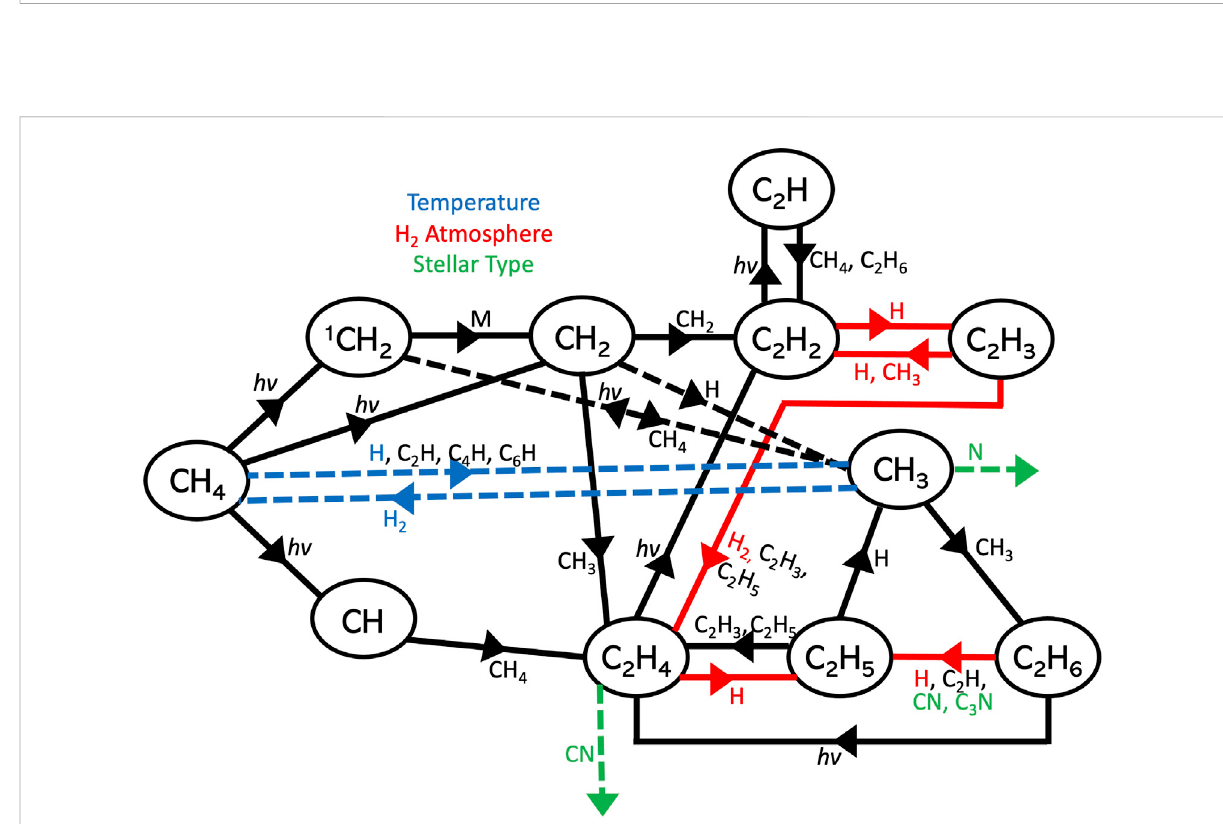
Diagram of important reactions relevant to hydrocarbon chemistry at Exo-Titans, based off the Titan chemistry presented in Yung et al. (1984). Reactions highlighted in blue show those with a large temperature dependence, thus dominating the chemistry in warmer atmospheres. Reactions highlighted in red show those which become signi fi cant in H 2 -dominant atmospheres. Reactions highlighted in green show those which become signi fi cant at worlds around